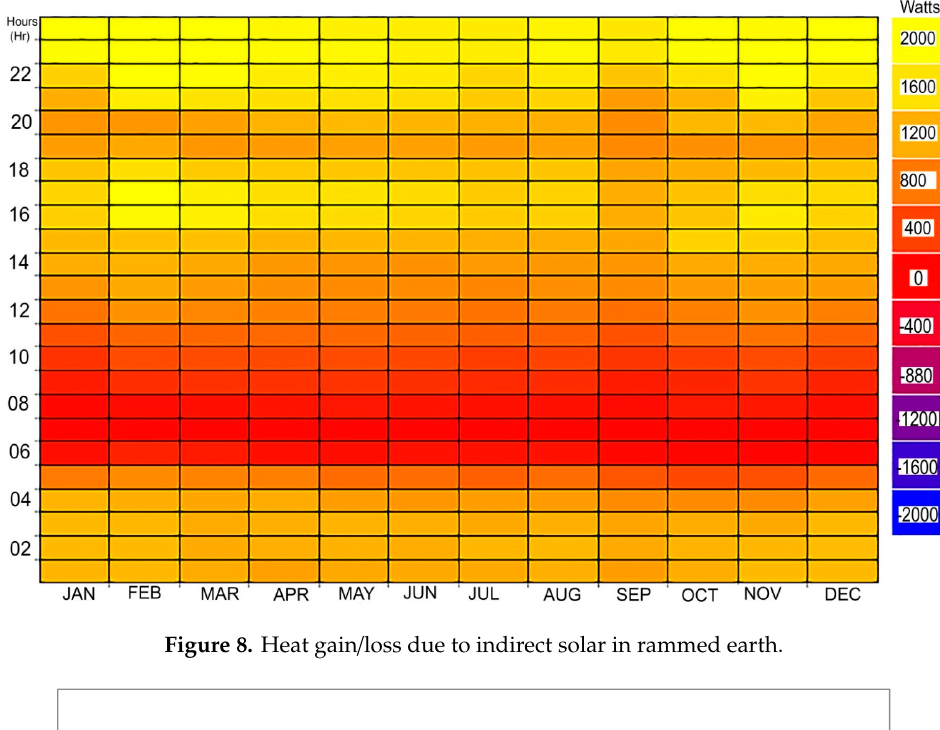
Figure 8. Heat gain / loss due to indirect solar in rammed earth. Figure 8. Heat gain/loss due to indirect solar in rammed earth. Figure 8. Heat gain/loss due to indirect solar in rammed earth.